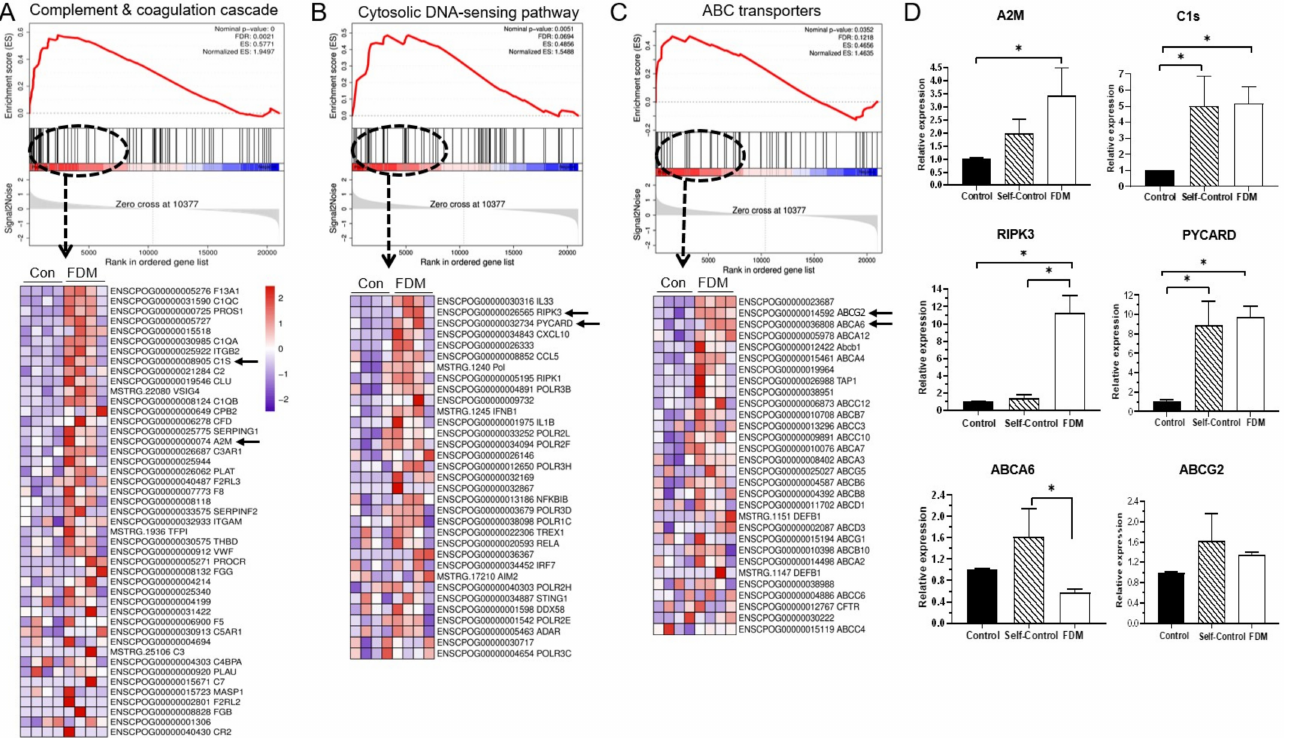
Figure 9. Gene set enrichment analysis (GSEA) of RNA-seq data from naïve control and FDM retinas. ( A – C ) GSEA enrichment plots and heat maps of leading edge genes of three gene clusters that are enriched in FDM retina were complement & coagulation cascade ( A ), cytosolic DNA-sensing pathway ( B ) and ABC transporters ( C ). Arrows indicating genes selected for qPCR verification. ( D ) Bar figures showing gene expression native control, self-control and FDM retinas. The value was expressed as gene fold change compared to naïve control. Mean ± SD, n = 6~8/group. * p < 0.05. One-way ANOVA followed by Fisher’s LSD